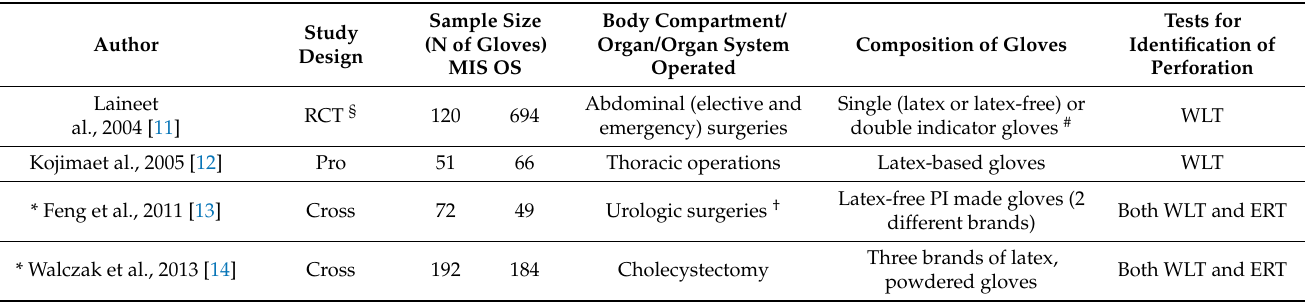
Table 1. Baseline characteristics of the included